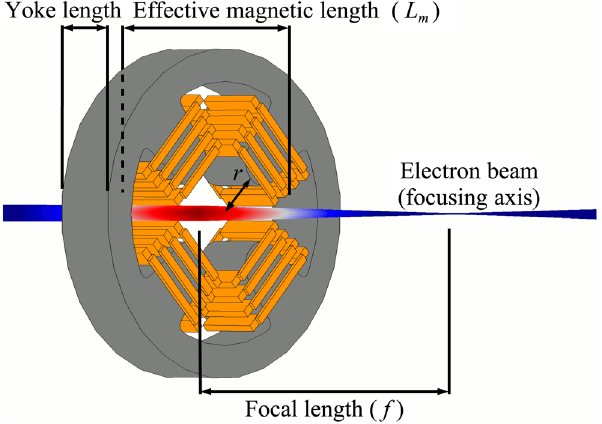
FIG. 1. Particle-tracking illustration of a 0.3 mm electromagnet gap radius, 0.2 mm yoke length MEMS quadrupole acting on an electron beam. The magnitude of the force on the electron beam is illustrated in color (e.g., red ¼ max force). The illustration perspective shows electron beam focusing on-axis of the quadru- pole; a perspective from the top would show defocusing of the electron